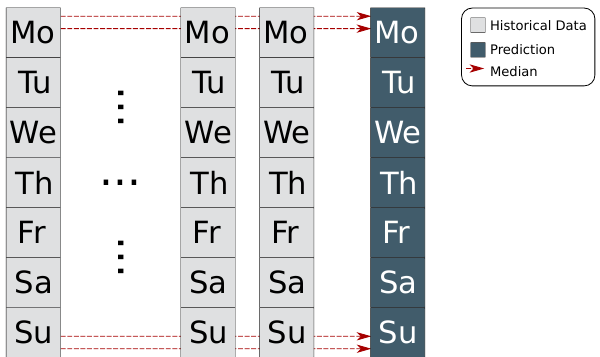
Figure 3. Illustration of the load prediction